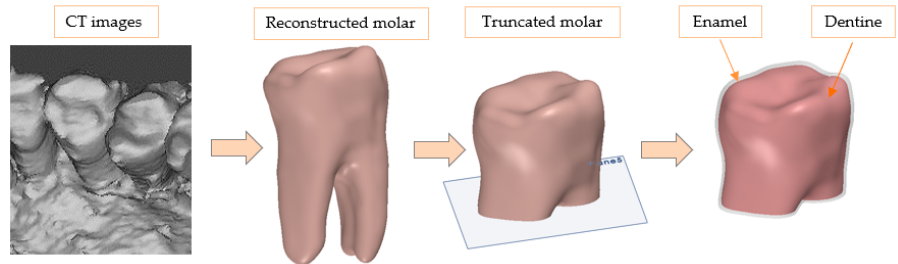
Figure 1. Stages of obtaining the basic geometric model.